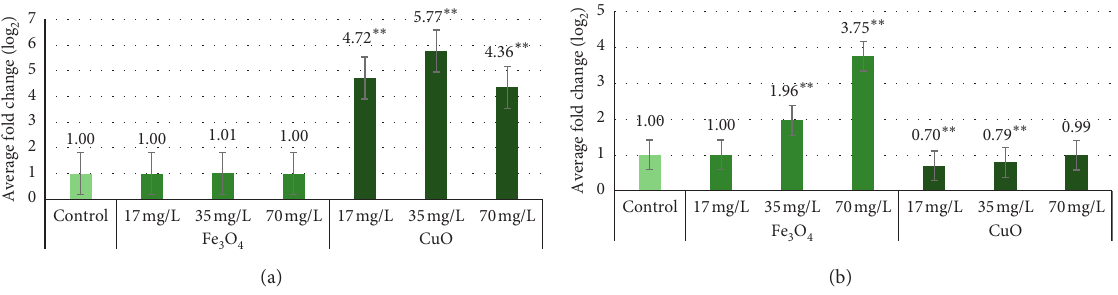
Control 17mg/L 35mg/L 70mg/L 17mg/L 35mg/L 70mg/L Fe Figure 5: Genome template stability in “Marthe” and “KWS Olof” varieties exposed to 17 mg/L, 35mg/L, and 70mg/L Fe concentrations. Values are the mean of three replicates with SD. ∗∗ Indicates a significant difference from control ( p < 0.01). (a) “Marthe” variety genome template stability (%) with Fe 3 O 4 and CuO NPs. (b) “KWS Olof” variety genome template stability (%) with Fe 3 O 4 and CuO NPs.